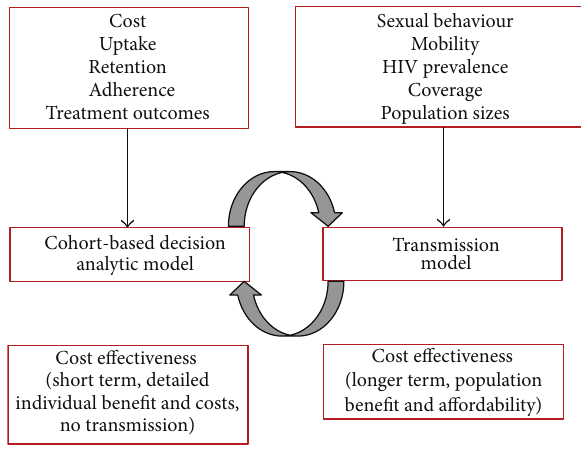
Figure 4: Schematic representation of the model-based